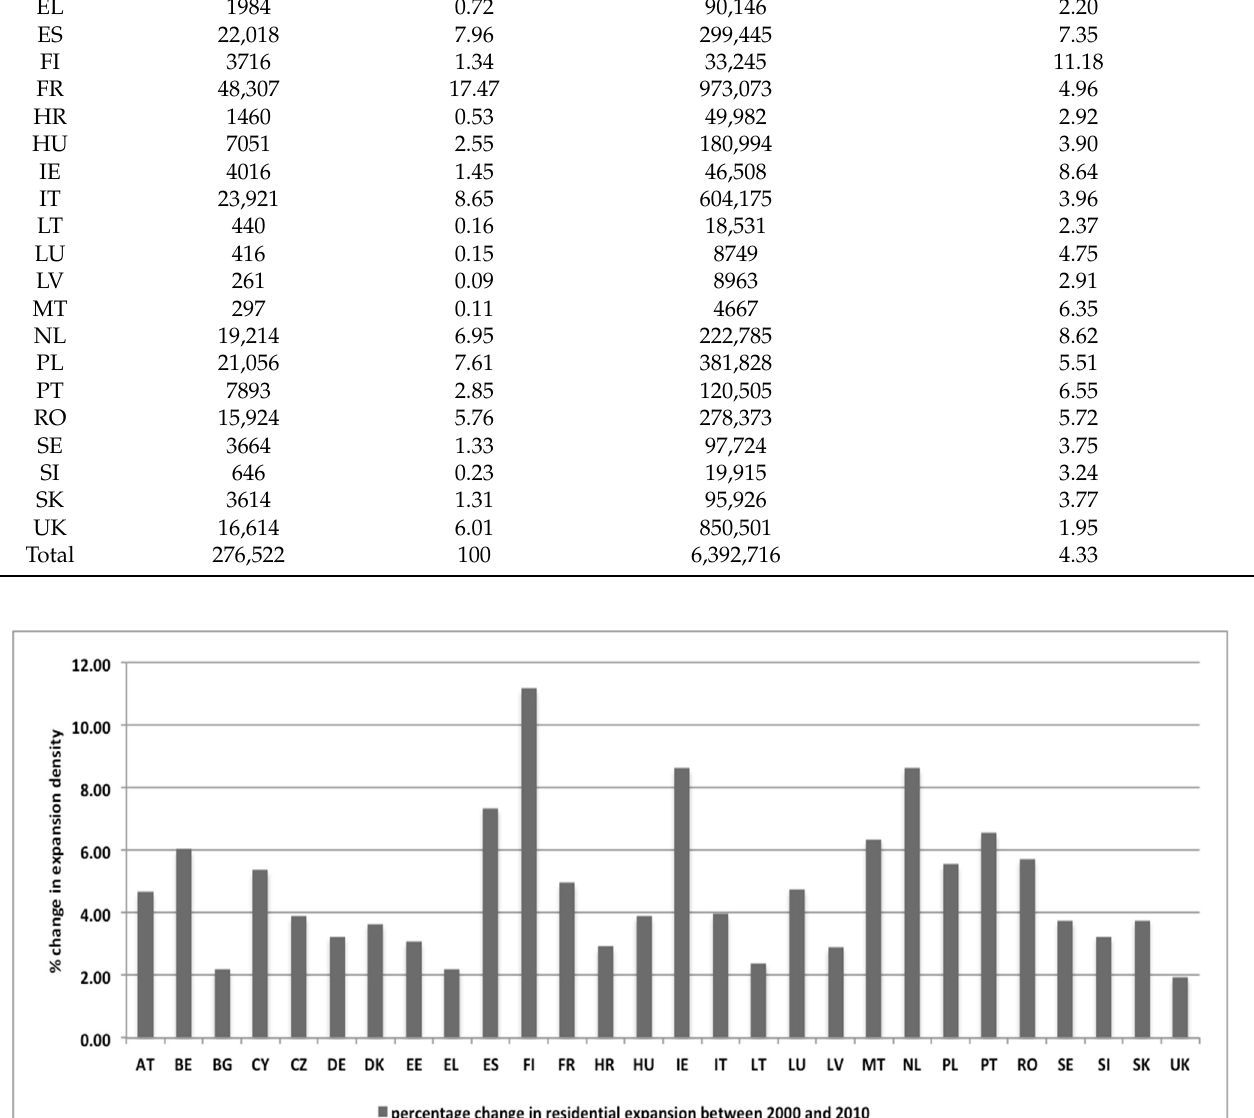
Figure 3. Percentage change in residential expansion densities between 2000 and 2010 in declining regions in Europe. Note: Belgium, Cyprus, Ireland, Luxembourg, and Malta are not included in the figure, considering that there are no declining regions in these countries. Table 2 shows that more than 275,000 hectares of new residential land were developed in the EU. The highest share of new development in the total residential area in a country was observed in Finland, followed by Ireland and the Netherlands, then Spain, Portugal, and Belgium (Figure 2). The UK and Bulgaria showed the lowest percentages of new residential development (Figure 2). Residential expansion occurred even in regions that declined considerably in population, for example, in Austria, Germany, Portugal, Romania, and Finland, among others. (See Figure 3). This may point to sprawled development, even under conditions of shrinkage [34,112]. Wolff et al. [39] claim that this type of urban development is dominant mainly in post-socialist countries and in Germany. From these results, it follows that processes of sprawl are much more widespread in Europe, confirming other studies that propose that in Europe, processes of urban sprawl are dominant and persistent, leading to low-density developments in many European countries if left unchecked [39,57,88,113]. Urban expansion and sprawl are considered to be two different terms explaining the physical development process in developing and developed countries/regions, respectively. Urban sprawl is generally characterised as a low-density, scattered, and leapfrog development pattern. By contrast, urban land expansion mainly observed in